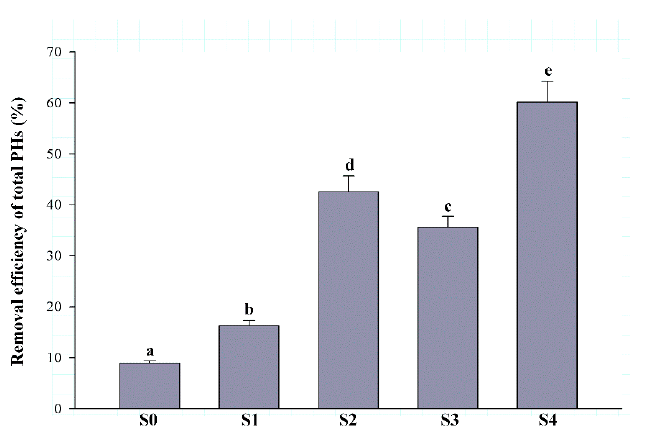
Figure 1. Removal e ffi ciency of total PHs from the contaminated soil. The error bars represent standard Figure 1. Removal efficiency of total PHs from the contaminated soil. The error bars represent deviations, n = 3. Lower-case letters indicate significant di ff erences at p < 0.05, represents initial standard deviations, n = 3. Lower-case letters indicate significant differences at p < 0.05, represents contaminated soils. initial contaminated soils. Table 3. Residual content of PHs in different remediation strategies.